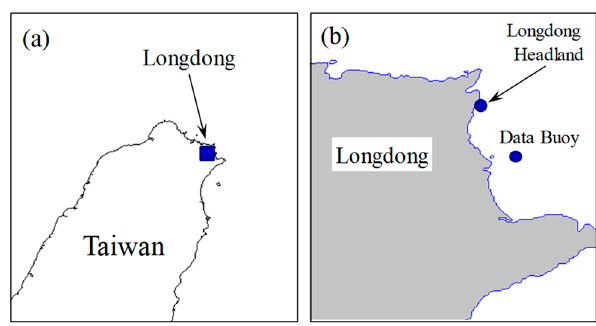
Figure 1. Map of ( a ) Longdong headland and ( b ) the Taiwan Central Weather Bureau (TCWB) data buoy.